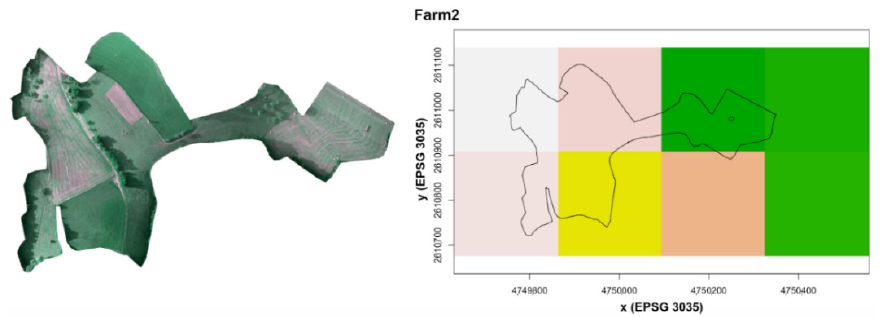
Figure 3. Drone scan image of Farm1e ( left ) and selected grid cell (marked with a small circle) for remote sensing based VHI in the permanent grassland area on Farm1e ( right —colours are not important, only cell layout is represented).